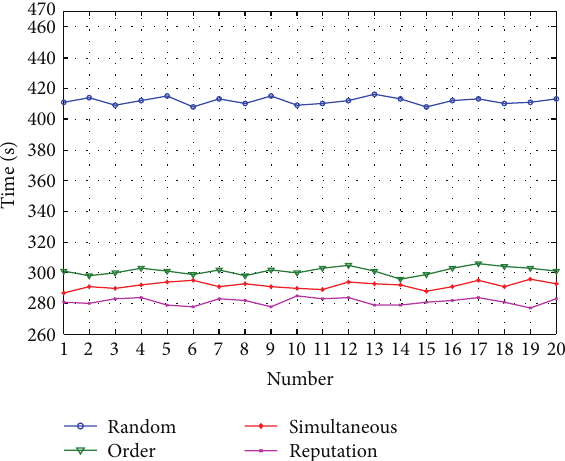
Figure 8: Comparison of the three allocation method.